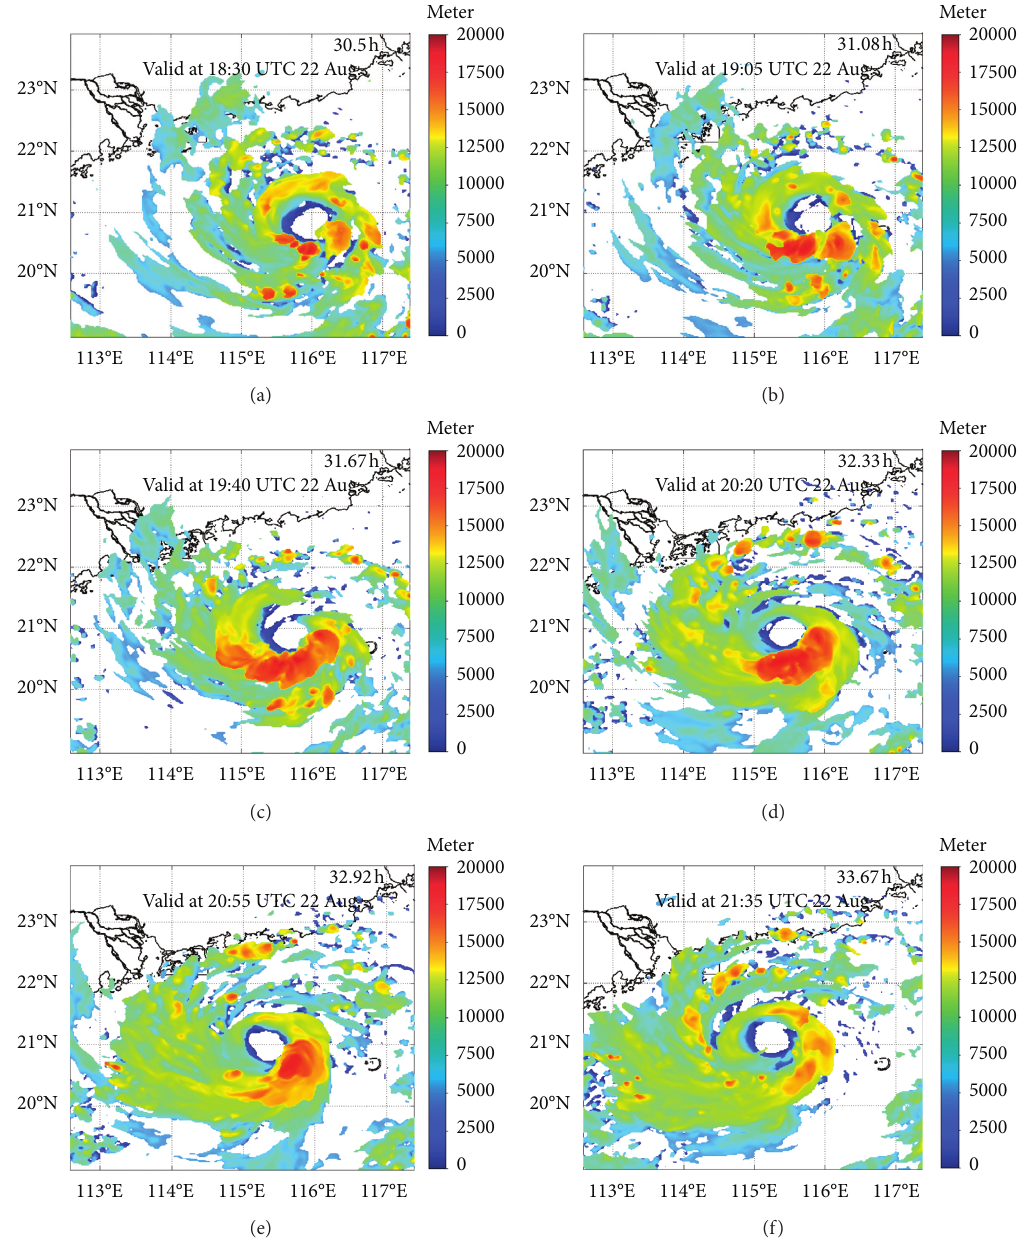
Figure 6: Peak height of radar composite reflectivity at 18dBZ derived from the WRF simulation at model hours (a) 30.5, (b) 31.08, (c) 31.67, (d) 32.33, (e) 32.92, and (f)